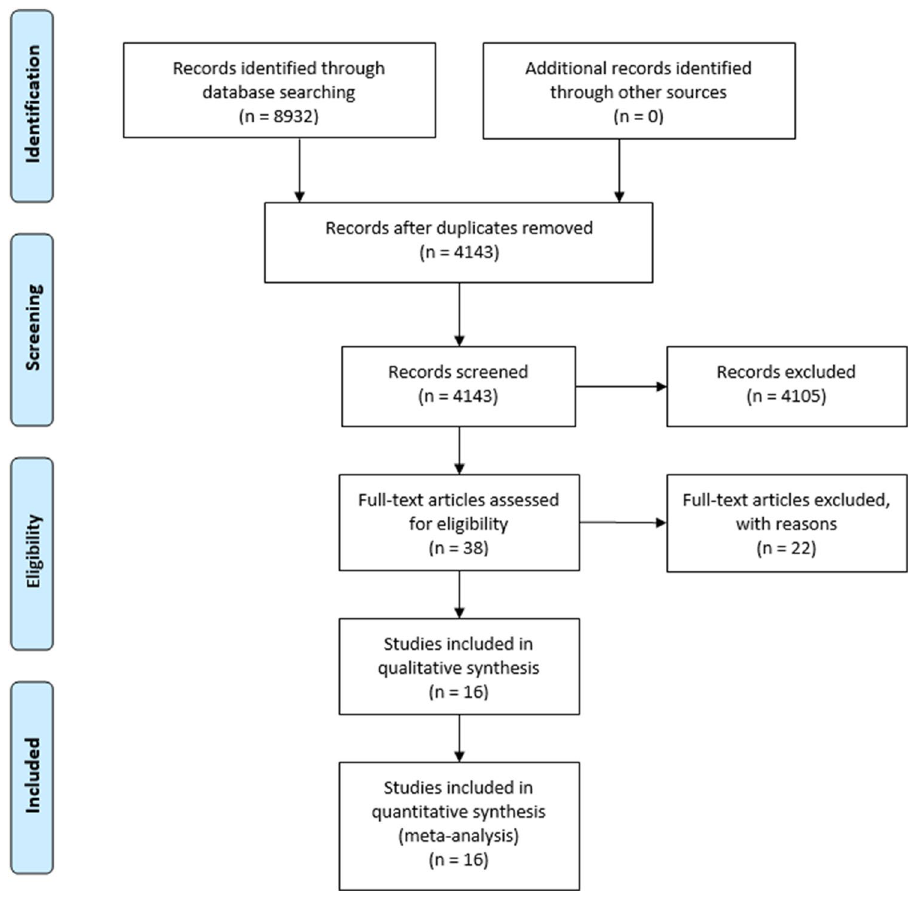
Figure 2. Flowchart of studies in